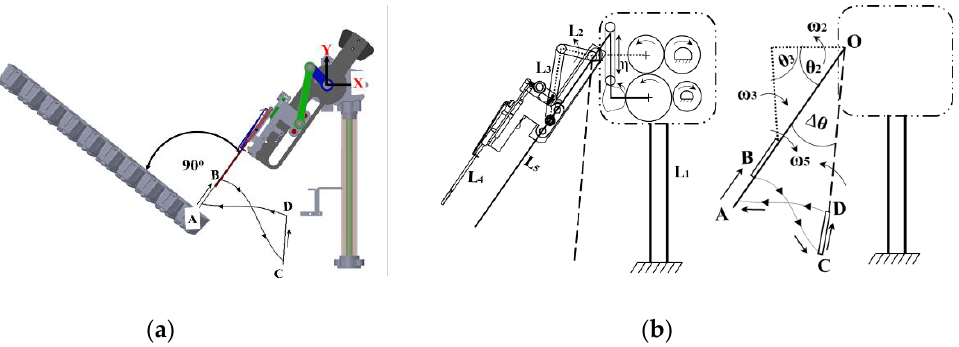
Figure 2. Schematic diagram of the picking device: ( a ) azimuth angle of the trajectory; ( b ) kinematic model for the picking device: ( L 1 ) picking stand, ( L 2 ) crank, ( L 3 ) connecting rod, ( L 4 ) gripper, ( L 5 ) manipulator, (A-B-C-D-A) trajectory path.